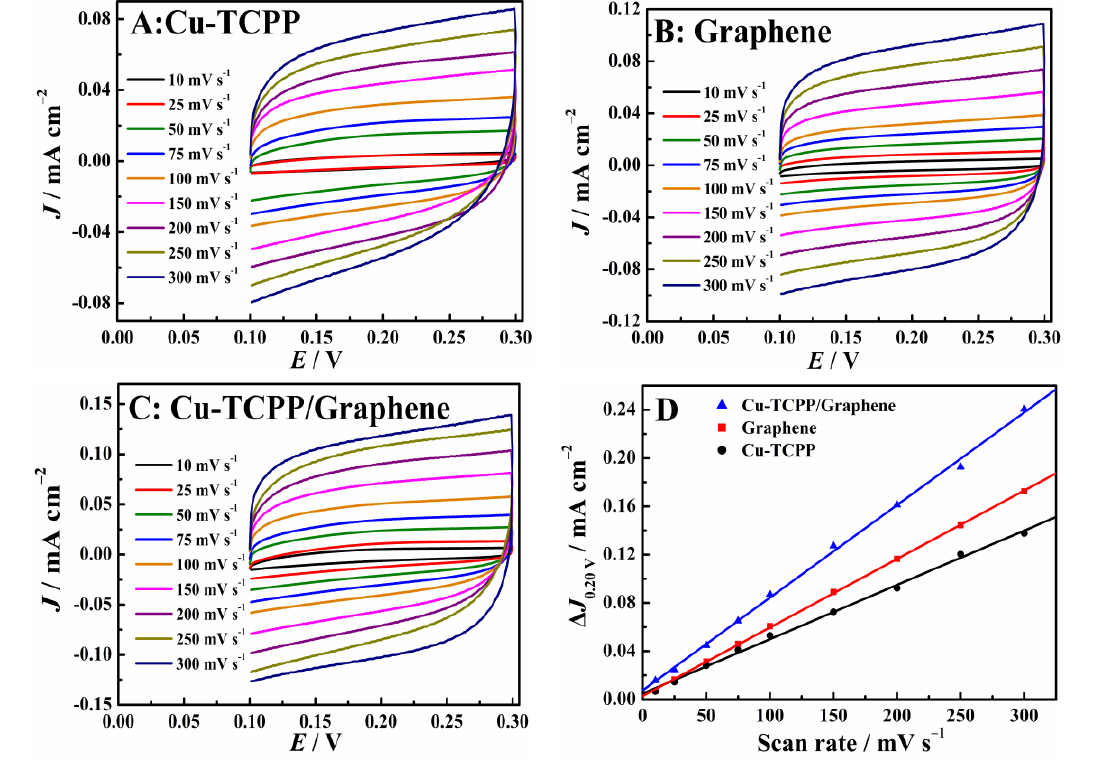
Figure 4. ( A – C ) CV curves of different materials with varied rates in 1 M KOH; ( D ) capacitive cur- rent at 0.20 V vs. scan rates.